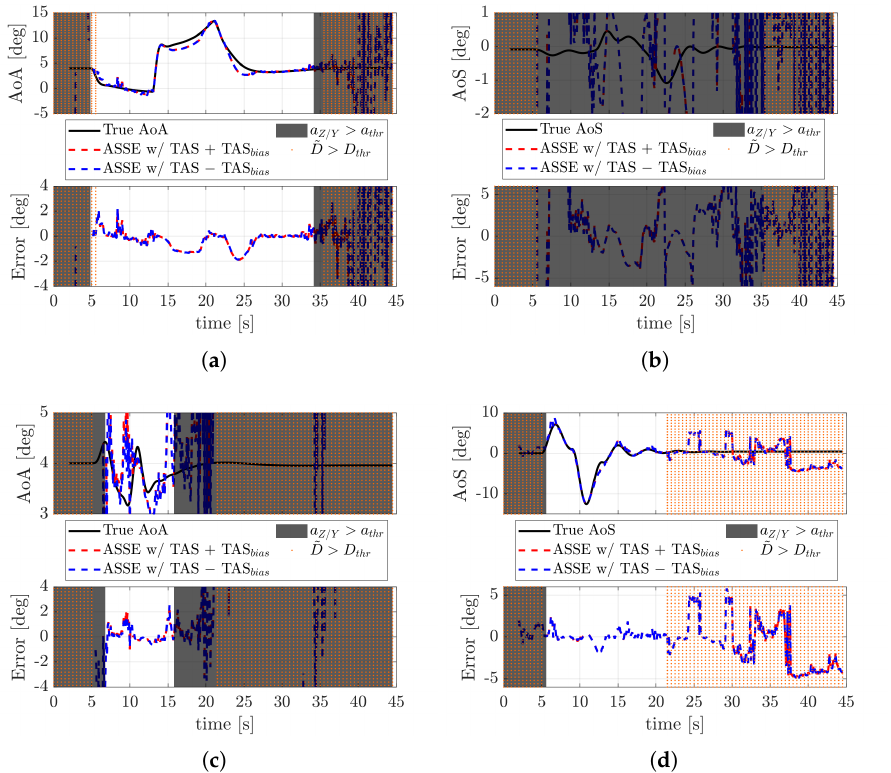
Figure 12. AoA and AoS estimation using the nonlinear ASSE scheme during the verification manoeuvres. The shaded areas indicate the regions where the corresponding inertial acceleration modules are below the predefined threshold a thr and the dotted areas indicate where the determinant is below a predefined threshold D thr . ( a ) AoA estimation during the stall manoeuvre, ( b ) AoS estimation during the stall manoeuvre, ( c ) AoA estimation during the sweep manoeuvre, ( d ) AoS estimation during the sweep